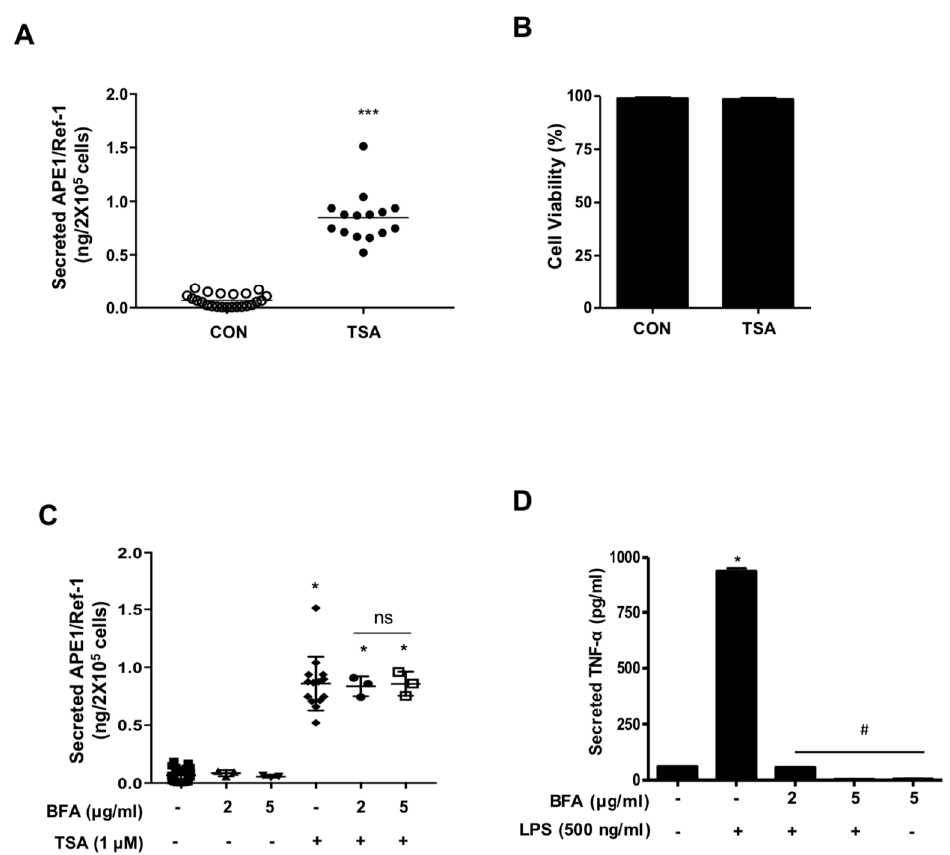
Figure 1. Secretion of APE1/Ref-1 was mediated by the non-classical pathway. ( A ) HEK293T cells were treated with 1 µM trichostatin A (TSA) for 1 h prior to collecting the cell-free supernatant. The total extracellular secretion of APE1/Ref-1 from acetylated HEK293T cells was measured by ELISA. Columns , mean ( n = 15-20); dot plot , SE. *** p < 0.001 indicates a significantly different result from control cells according to an unpaired t- test. ( B ) Effects of TSA on the viability of HEK293T cells were determined using a bioluminescent assay Columns , mean ( n = 6); bars , non- significantly different from control cells according to an unpaired t- test. ( C ) HEK293T cells were pretreated with brefeldin A (BFA), a classical secretory pathway inhibitor, followed by 1 µM TSA treatment for 3 h. The total amount of secreted Ac-APE1/Ref-1 in cell-free supernatant was analyzed by ELISA. ( D ) The total amount of secreted TNF- α from LPS-stimulated RAW 264.7 cells before exposure to BFA at the indicated concentration. Column, mean ( n = 5); bars , SE. * ,# , p < 0.05 indicates a significantly different result compared with control or between groups by one-way ANOVA followed by Bonferroni’s multiple comparison test.